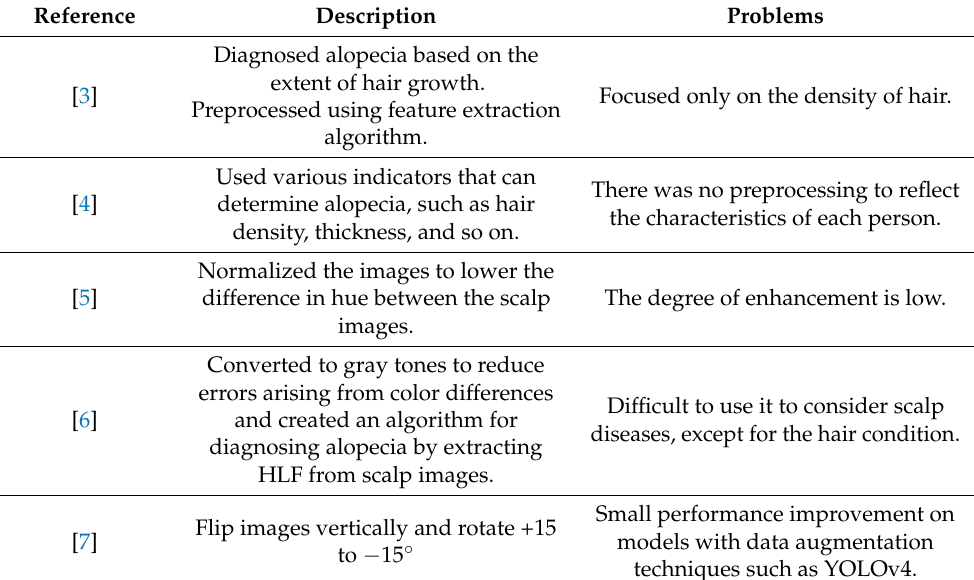
Table 1. Summary of the existing scalp data preprocessing